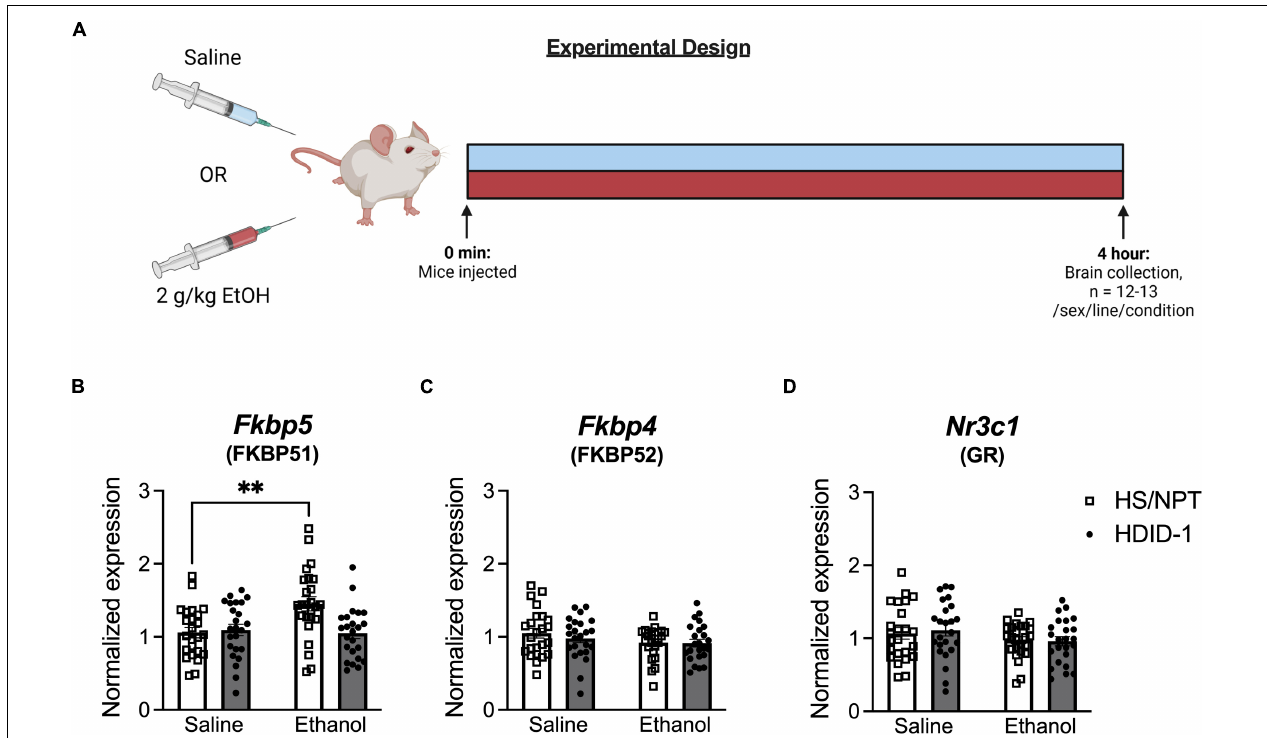
FIGURE 3 | HDID-1 mice fail to exhibit ethanol-induced increase in Fkbp5 expression. (A) Separate groups of HDID-1 and HS/NPT mice were given either a 2 g/kg ethanol injection or an equivalent volume of saline and brains were collected 4 h later for gene expression analysis in the NAc. (B) Ethanol injection produced an increase in Fkbp5 expression in the HS/NPT mice that was not evident in HDID-1 mice. (C,D) No group differences were observed in either Fkbp4 or Nr3c1 expression. Means ± SE shown. ∗ p <